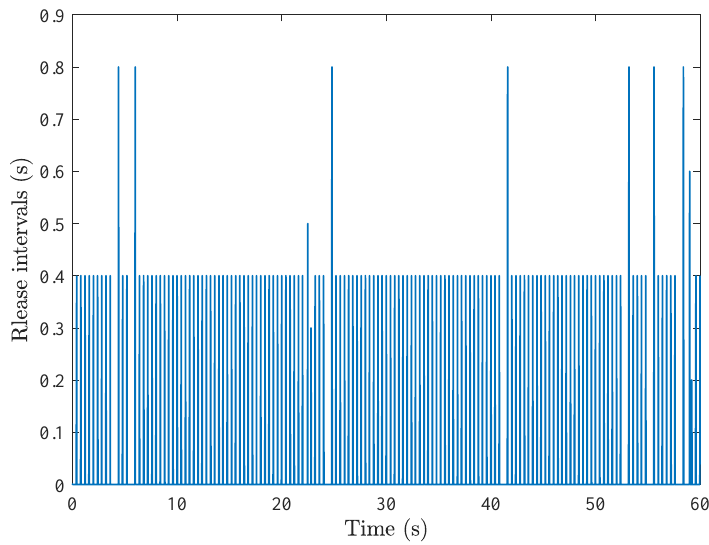
Figure 10. Event-triggered instants of sensor